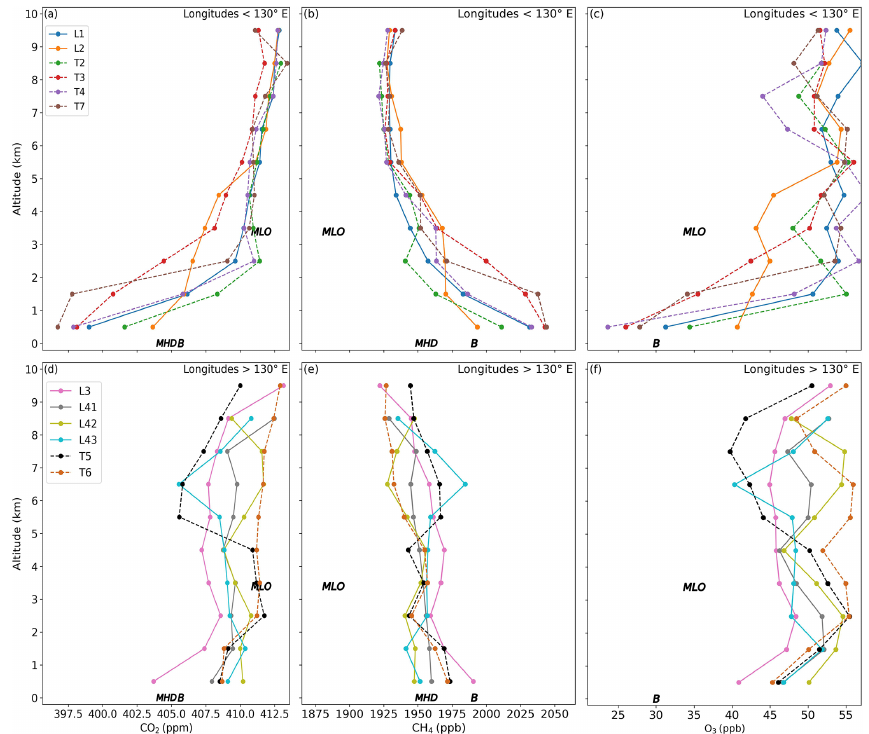
Figure 5. Flight mean vertical mixing ratio profiles for CO 2 (a, d) , CH 4 (b, e) , and O 3 (c, f) . Top row shows flights west of 130 ◦ E, while the bottom row shows flights east of 130 ◦ E. Flight T1 is not shown due to missing data. Monthly mean values at Mauna Loa (MLO), Mace Head marine sector (MHD), and Barrow (B) in September 2020 are shown in each